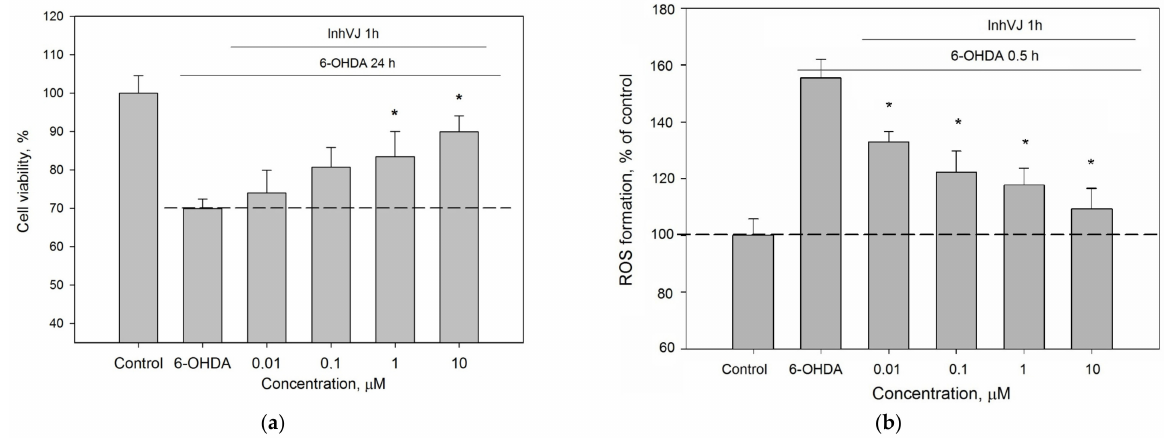
Figure 6. Concentration-dependent influence of InhVJ on ( a ) Neuro-2a cell viability after 24 h incubation with 25 µ M of 6-OHDA. ( b ) ROS formation in Neuro-2a cells induced by 6-OHDA during 0.5 h. Each bar represents the mean ± SEM of three independent replicates. Differences between 6-OHDA-treated cells incubated alone (designated by the dotted line) or with InhVJ are statistically significant with * p < 0.05.